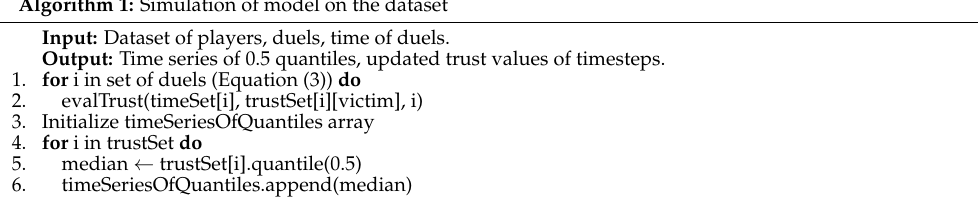
Algorithm 1: Simulation of model on the